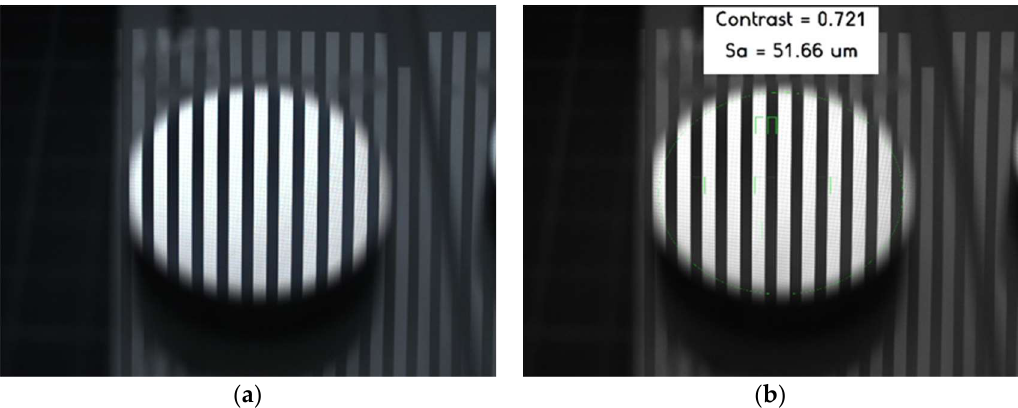
Figure 5. Image processing for surface roughness measurement. ( a ) Original image; ( b ) result display.